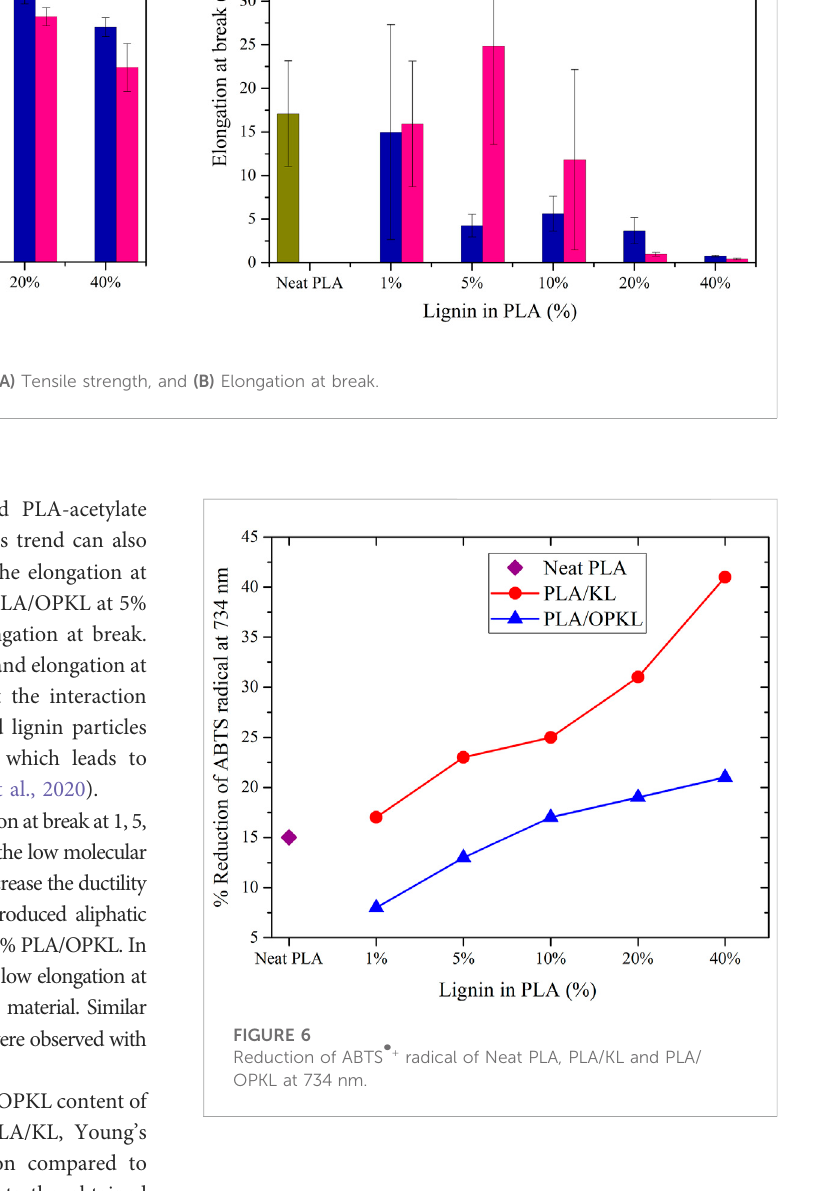
FIGURE 6 Reduction of ABTS OPKL at 734